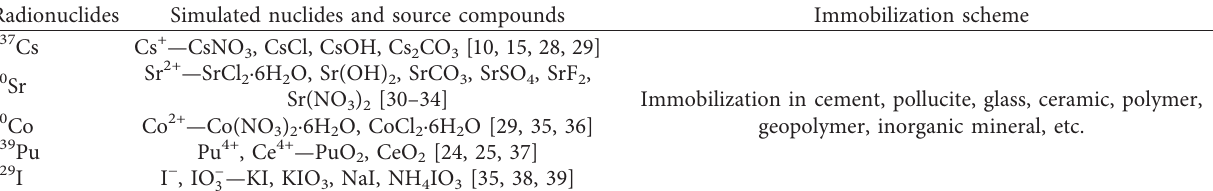
Table 2: Simulated radionuclides commonly used in former studies. Radionuclides Simulated nuclides and source compounds Immobilization scheme 137 Cs Cs + —CsNO 3 , CsCl, CsOH, Cs 2 CO 3 [10, 15, 28, 29] Immobilization in cement, pollucite, glass, ceramic, polymer, geopolymer, inorganic mineral,